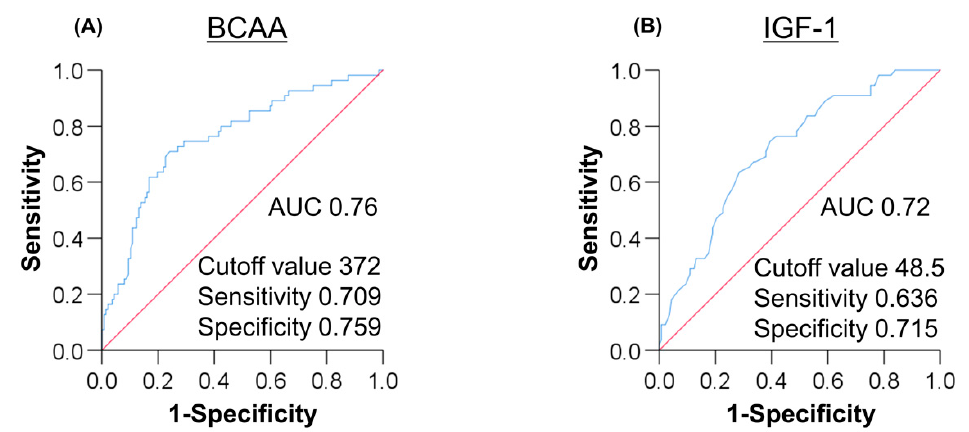
Figure 3. ( A ) The ROC curve analysis of branched-chain amino acid (BCAA) for predicting sarcopenia in patients with liver cirrhosis (LC). The BCAA cutoff value was 372 μ mol/L with AUC, specificity, and sensitivity of 0.760, 0.709, and 0.759, respectively. ( B ) The ROC analysis of insulin-like growth factor 1 (IGF-1) for predicting sarcopenia in patients with LC. The IGF-1 cutoff value was 48.5 ng/mL with AUC, specificity, and sensitivity of 0.720, 0.636, and 0.715, respectively. AUC, area under the curve; ROC, receiver operating characteristic.